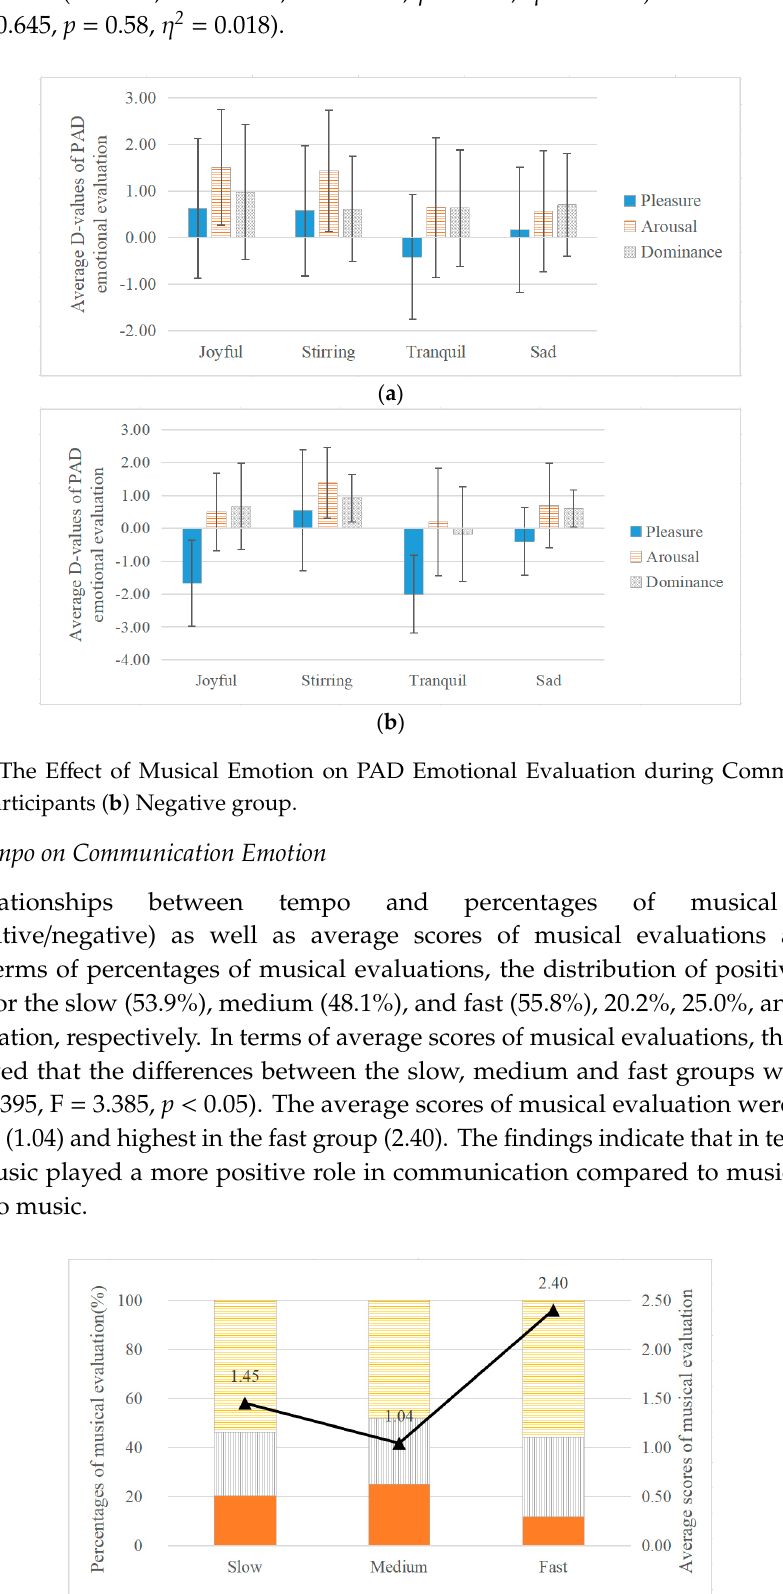
Figure 7. The Effect of Musical Tempo on Musical Evaluation during Communication.